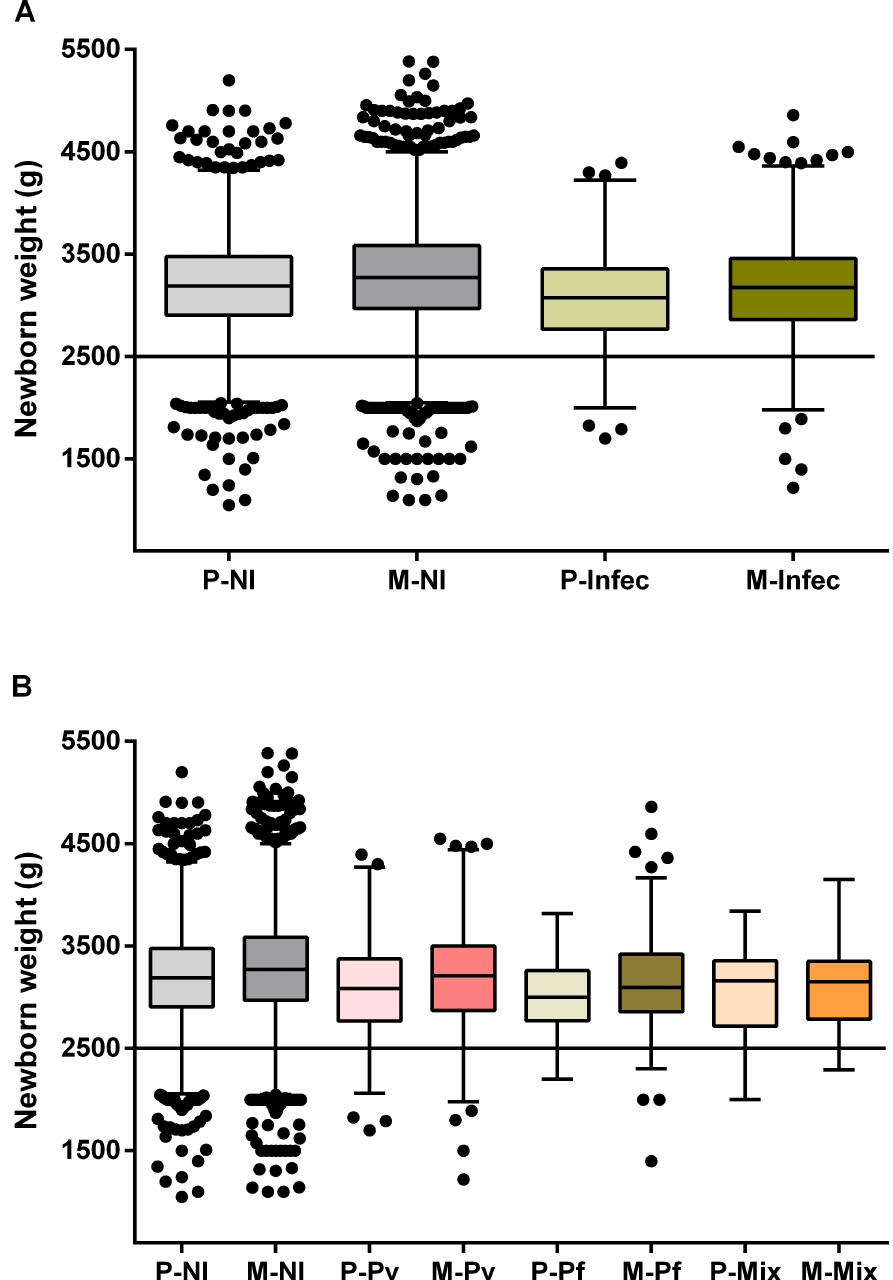
Fig 5. Impact of malaria on birth weight at term according to gravidity. Tukey boxplots show the effect of gravidity on the weight of newborns from malaria-infected women (A), and on newborns from women infected according with Plasmodium species (B). The bottom and the top of the box are the first and third quartiles, the line inside the box is the median, and the whiskers represent the lowest and the highest data within 1.5 IQR of the first and upper quartiles. The line indicates the cut-off of low birth weight. Differences between each group were examined with Mann-Whitney or Kruskal-Wallis test with a Dunn’s post hoc test. (A) P—NI x Infec (p < 0.0001); M—NI x Infec (p < 0.0001); NI- P x M (p < 0.0001); and Infec—P x M (p = 0.0004). (B) P—NI x Pv (p = 0.0001); NI x Pf (p = 0.0003); M—NI x Pv (p = 0.0009); NI x Pf (p < 0.0001); NI x Mix (p = 0.003); Pv x Pf (p = 0.025); Pv—P x M (p = 0.0009). P, primigravida; M, multigravida; NI, non-infected pregnant women; Infec, infected pregnant women; Pv, P . vivax -infection; Pf, P . falciparum -infection; Mix, mixed-infection.